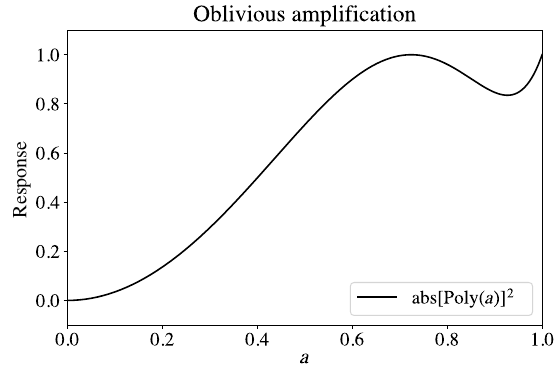
FIG. 20. The transition probability using the polynomial for oblivious amplification for d = 10 and δ = 0.5.